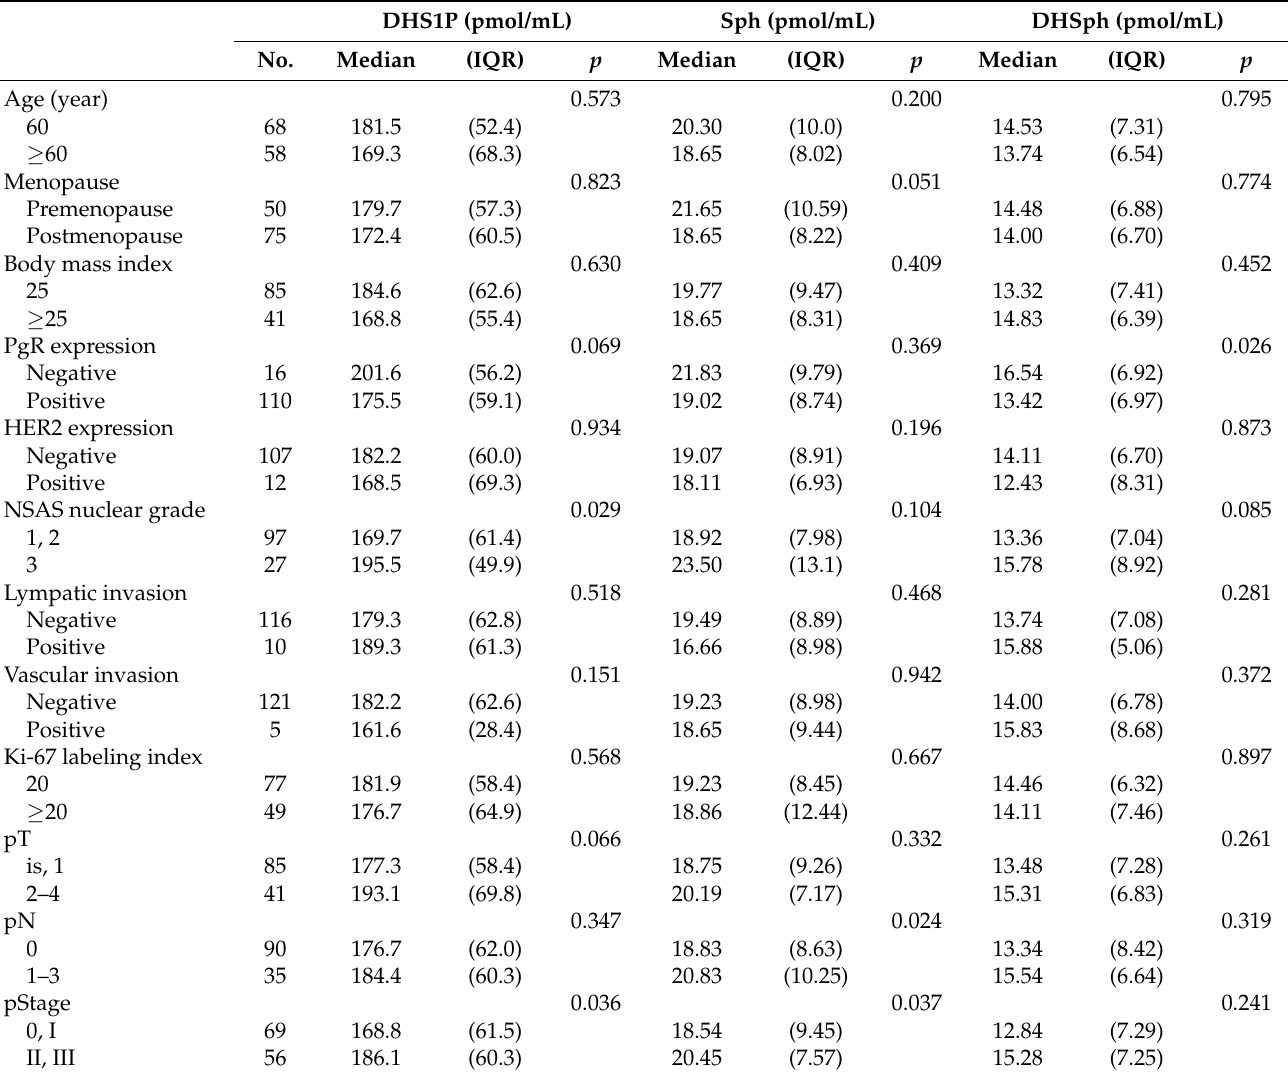
Table 2. Levels of DHS1P, Sph, and DHSph in plasma of estrogen receptor-positive breast cancer